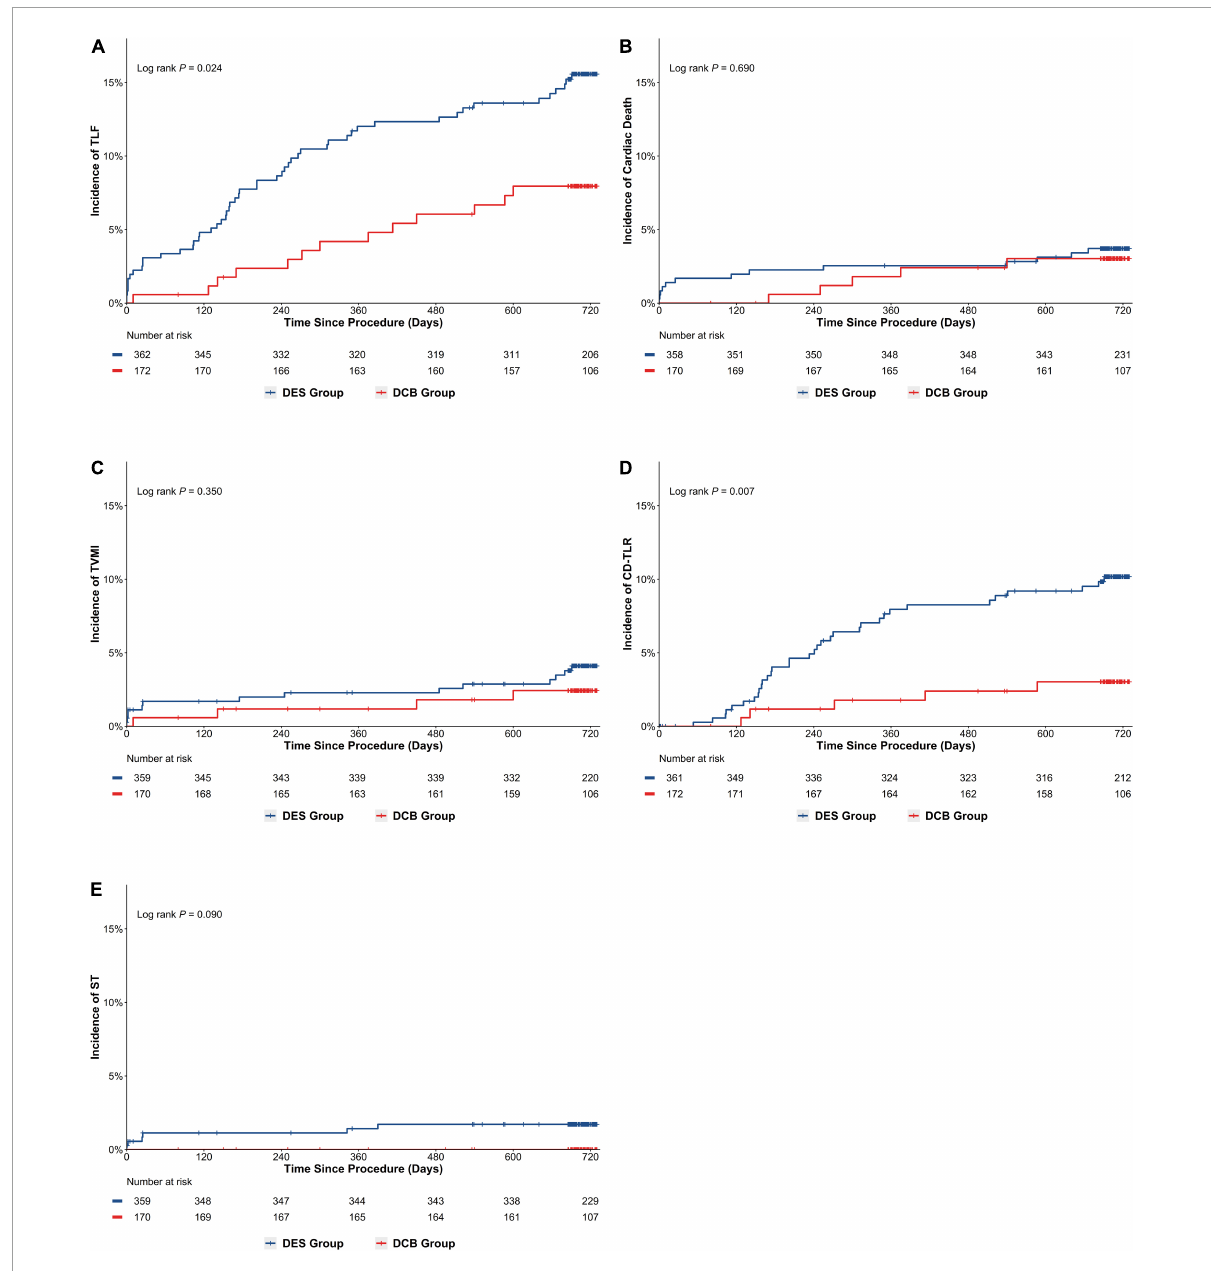
FIGURE3 Cumulative risks of the study outcomes in the matched cohort (Kaplan–Meier time-to-first event curves). (A) TLF; (B) cardiac death; (C) TVMI; (D) CD-TLR; (E) ST. TLF, target vessel failure; TVMI, target vessel myocardial infraction; CD-TLR, clinically driven target lesion revascularization; ST, stent